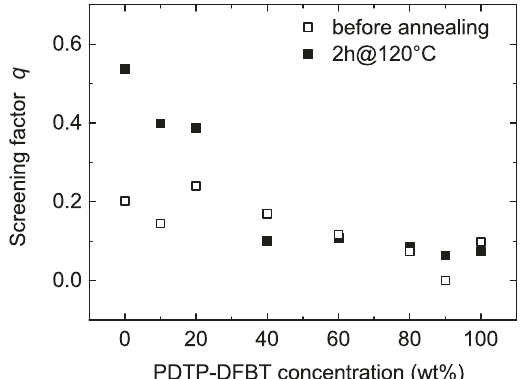
Fig. 5 The evolution of the screening factor q of ternary PTB7-Th: PDTP – DFBT:PC 61 BM blends versus the PDTP – DFBT concentration x before ( open squares ) and after annealing ( closed squares